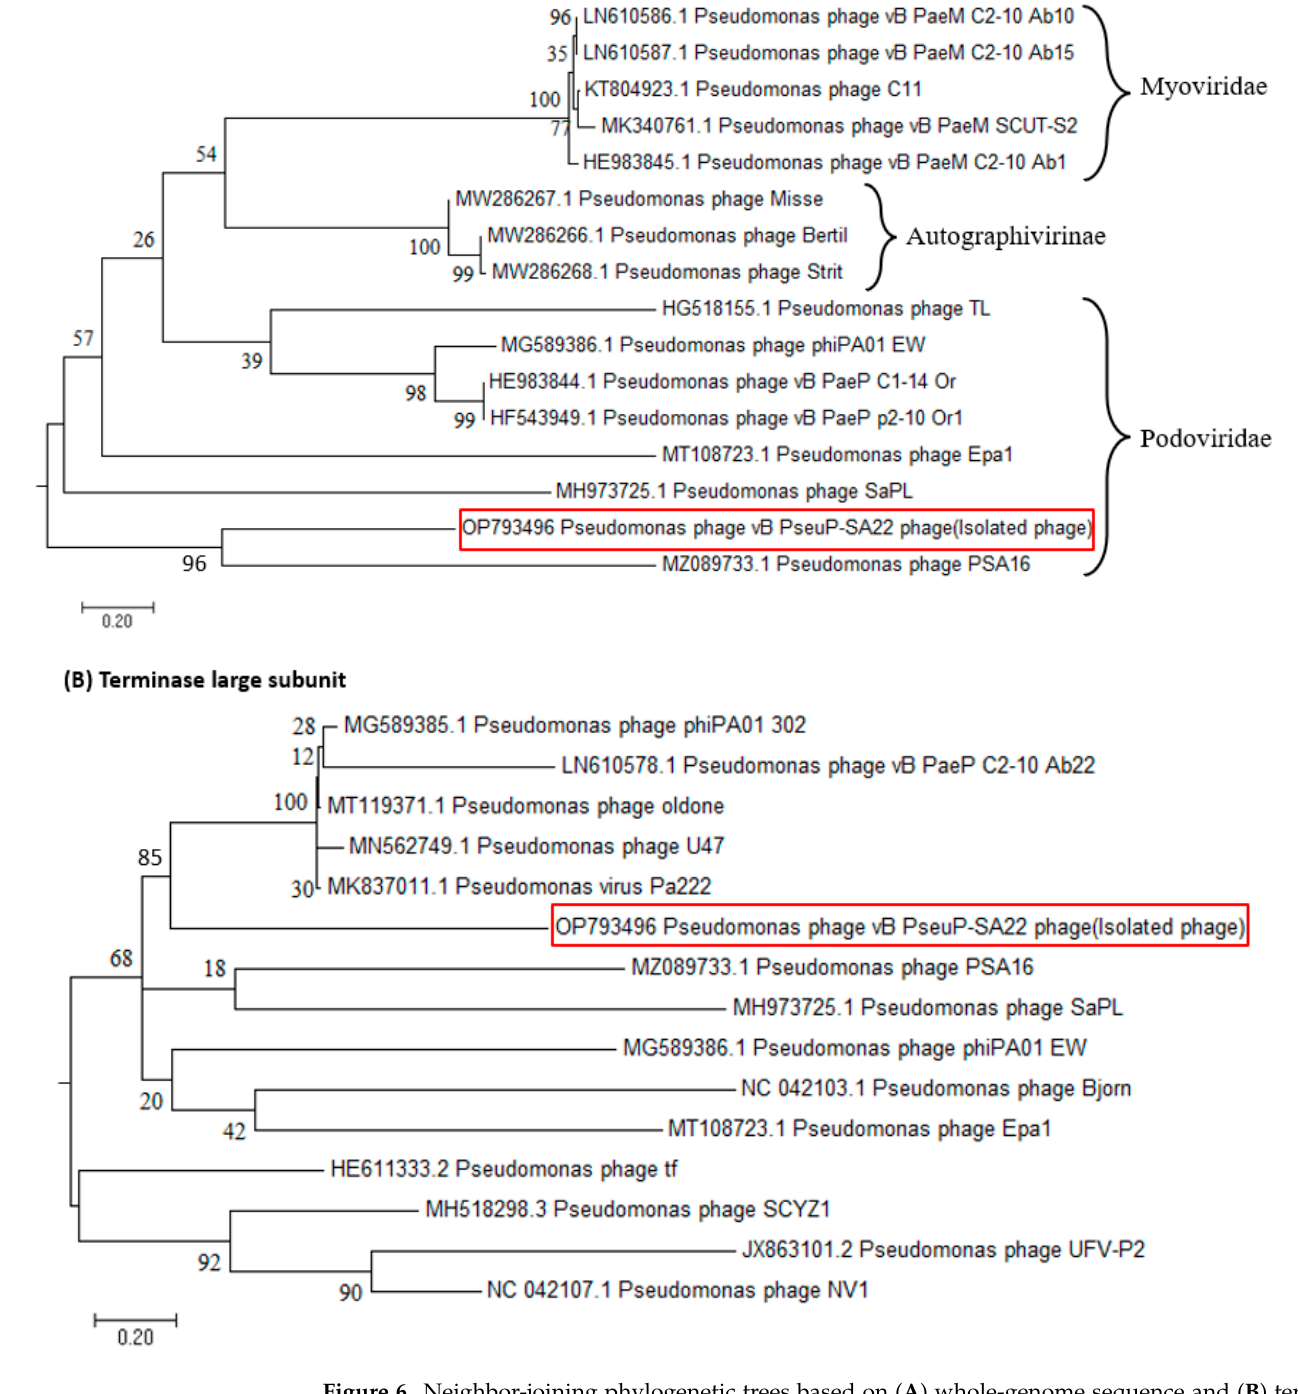
Figure 6. Neighbor-joining phylogenetic trees based on ( A ) whole-genome sequence and ( B ) ter- minase large sub-unit of vB_PseuP-SA22. The red color indicates the position of vB_PseuP-SA22. Reference phage sequences were obtained from the above-mentioned